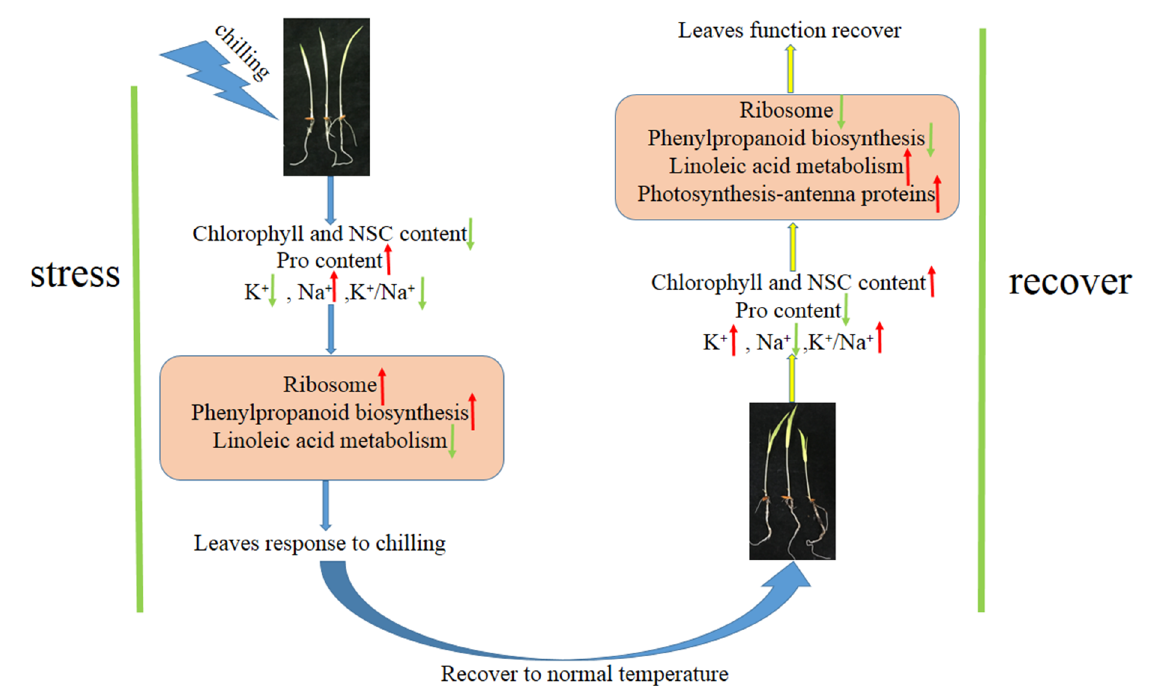
Figure 10. The pathway of leaves response to environmental conditions. Red arrows represent upregulation; green arrow represent downregulation.